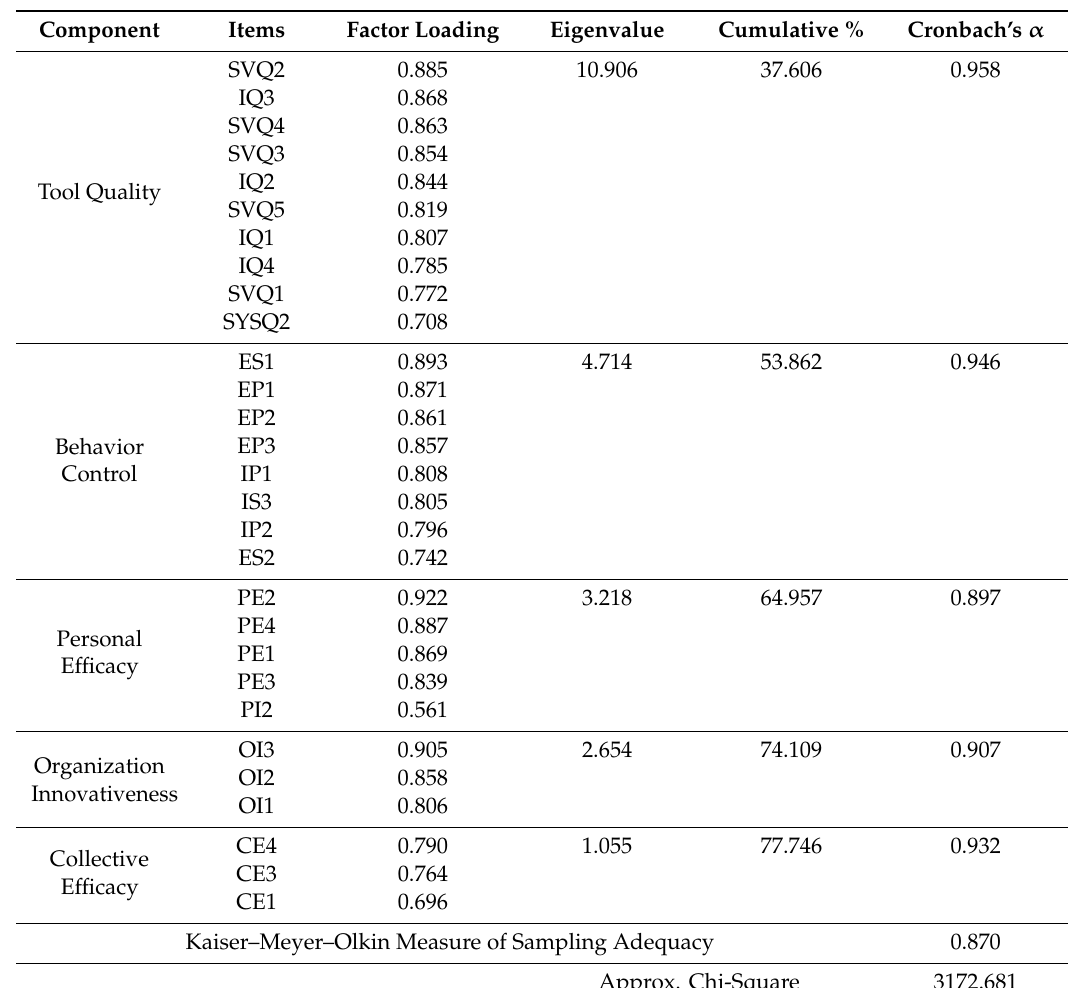
Table 3. Results of the factor